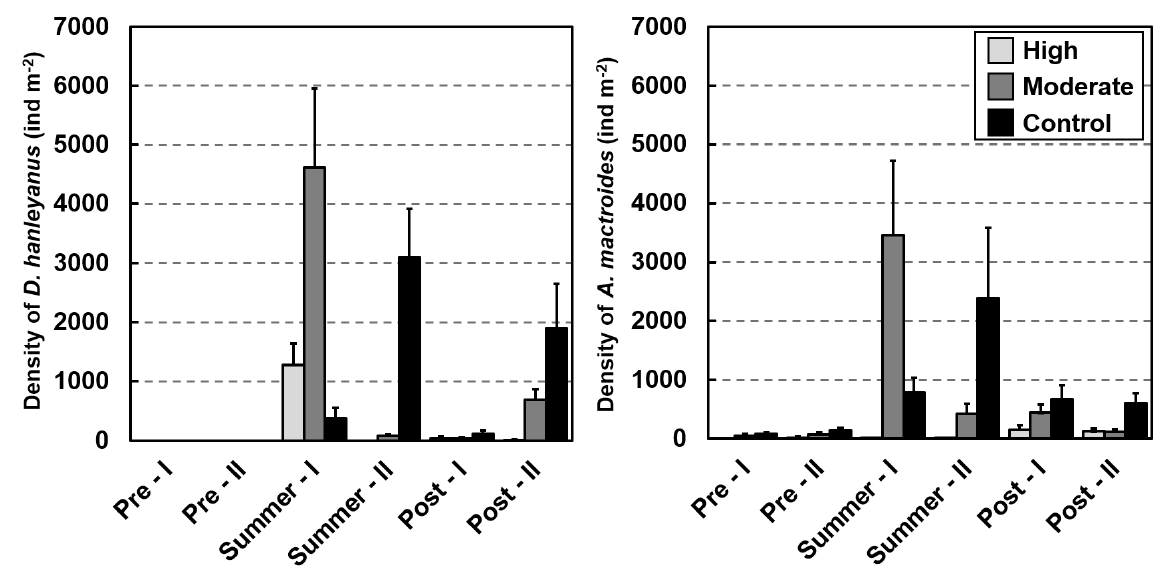
Figure 4. Percentage of each size class of D. hanleyanus (a) and A. mactroides (b) in the different sampling periods for the High Impact, Moderate Impact and Control sectors. Colors represent each size class: black (recruits); light gray (juveniles); and dark gray (adults). Asterisks represent periods in which the presence of bivalves was not